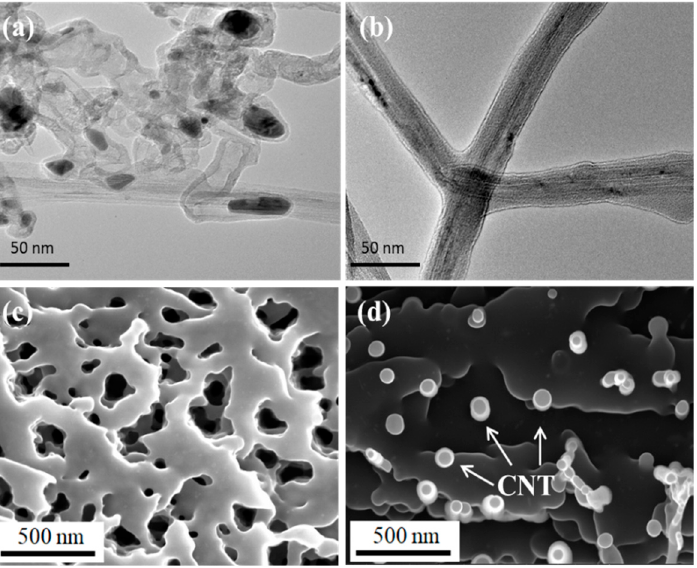
Table 2. The mass percentage of different components of CNT film and CNTF/MPC nanocompo- sites.